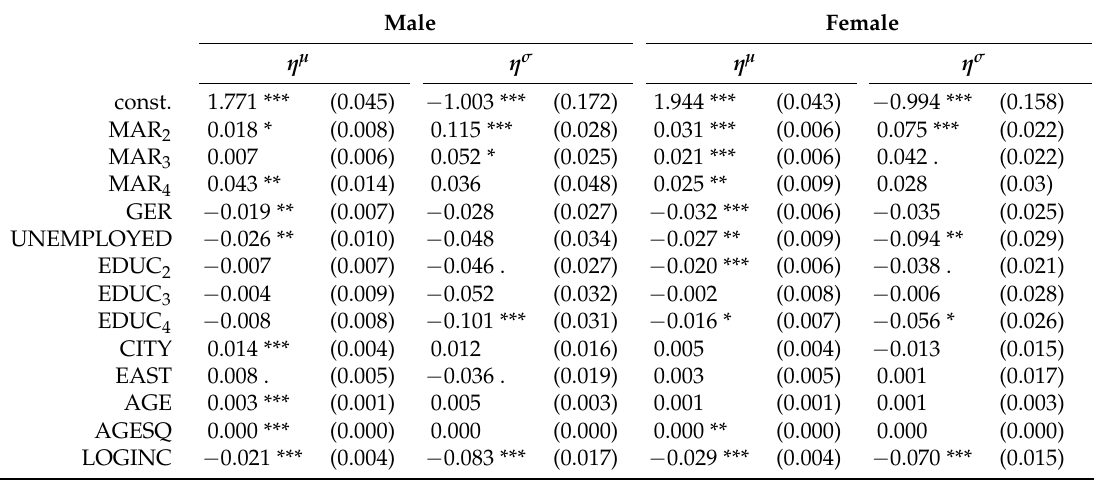
Table 1. Linear effects of η µ and η σ for MCS in the Gamma model, with standard errors in